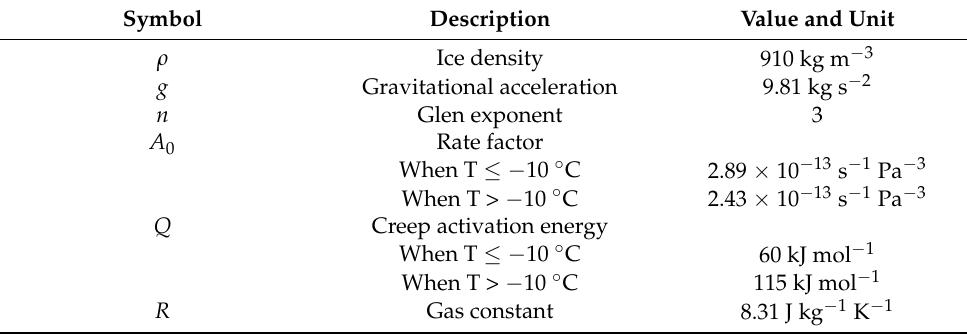
Table 2. The parameter of the ice-flow